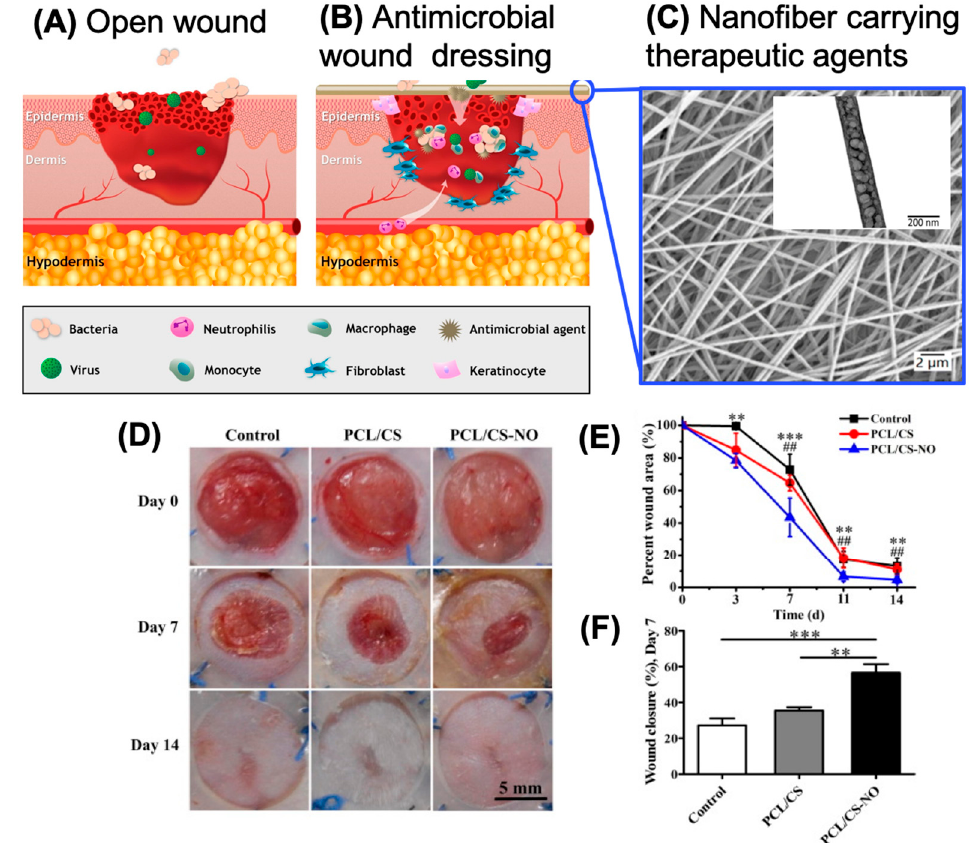
Figure 6. The wound healing process of ( A ) an open wound covered with ( B ) an antimicrobial wound dressing. When the antimicrobial dressing covers the wound bed, it acts as a barrier to prevent bacteria and viruses from invading the wound. Dressings with embedded functional agents can promote the healing rate and stimulate the immune system to speed up skin regeneration in immunocompromised patients. Reprinted with permissions from [101] , copyright 2018 Elsevier. An example in ( C ) shows chitosan-based nanofibers with 0.3% w/v of polyhexanide (a commonly used wound disinfectant) embedded, used to fabricate an antimicrobial surface on a surgical dressing. Reprinted with permissions from [102] , copyright 2020 Springer. ( D ) In vivo wound healing in a mouse model using a PCL-chitosan nanofibrous dressing with or without incorporated nitric oxide. The nitric oxide-containing material promotes faster wound closure, as illustrated in ( E ) by the percentage of open wound area and in ( F ) by the percentage of wound closure. Reprinted with permissions from [109] , copyright 2018 Elsevier. ** p < 0.01, *** p < 0.001, ## p < 0.05.